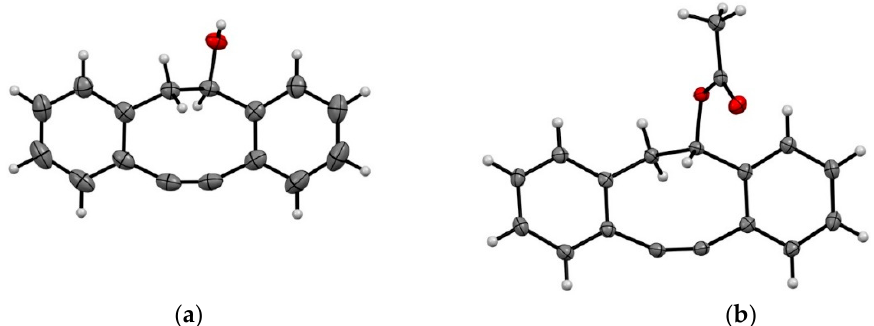
Figure 5. X-Ray crystal structures of ( R )- 1 ( a ) and ( S )- 2 ( b ) with thermal displacement parameters shown at the 50% probability level.